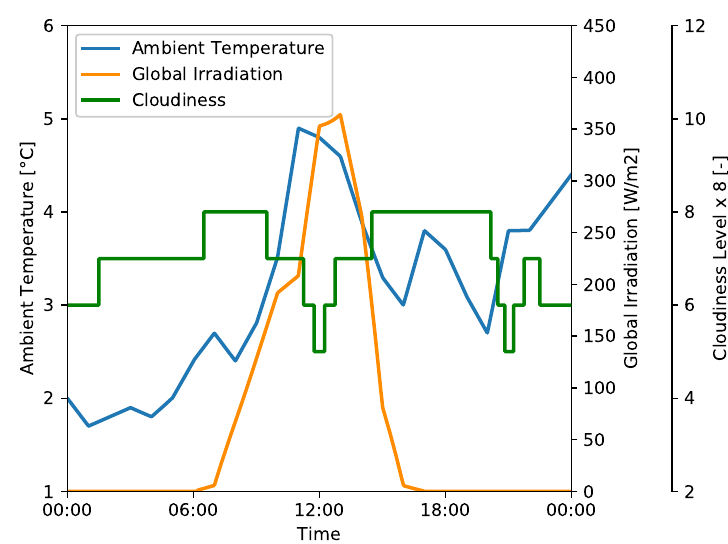
Figure 4. A winter cloudy type day temperature and global